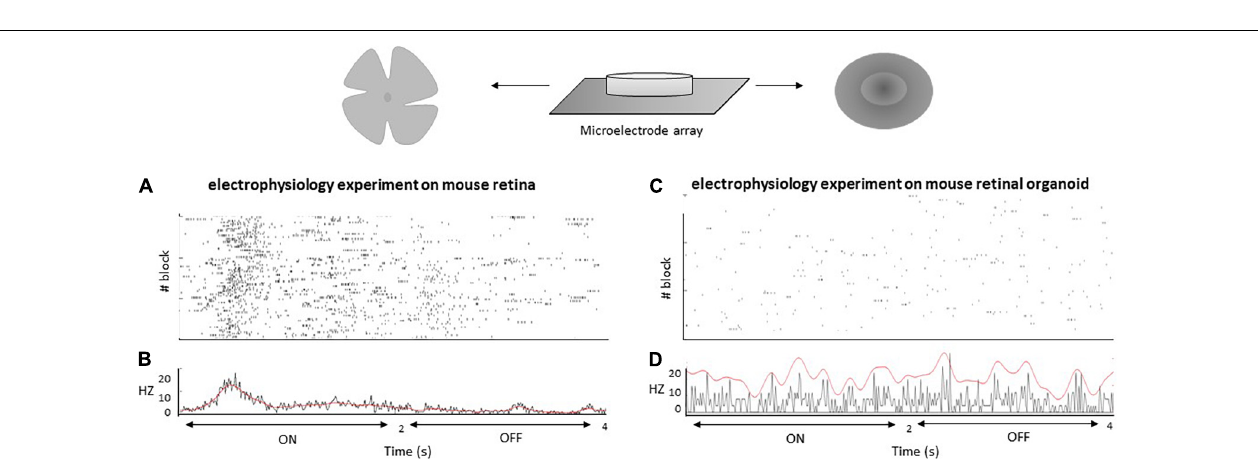
FIGURE 2 | Summary of major challenges in retinal organoid technology: (A) lack of vasculature, (B) RPE orientation for the visual cycle, (C) mature ON and OFF pathways, and (D) proper cell orientation and synaptogenesis.